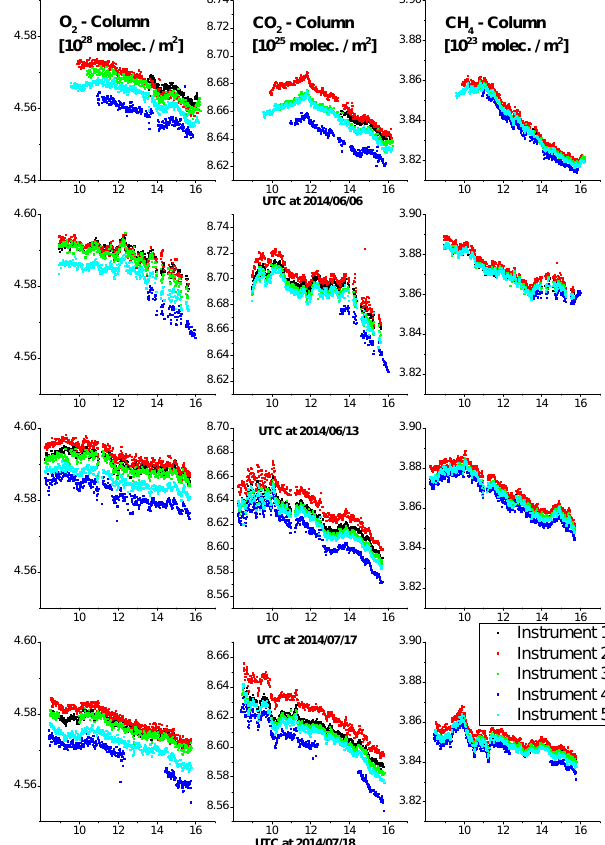
Figure 5. Total columns of O 2 , CO 2 and CH 4 for the different spec- trometers on 4 days of the calibration measurements in Karlsruhe. Solar observations were performed in June and July 2014, in be- tween the spectrometers were transported for campaign measure- ments. One data point consists of 10 interferograms, the measure- ment time being 58s